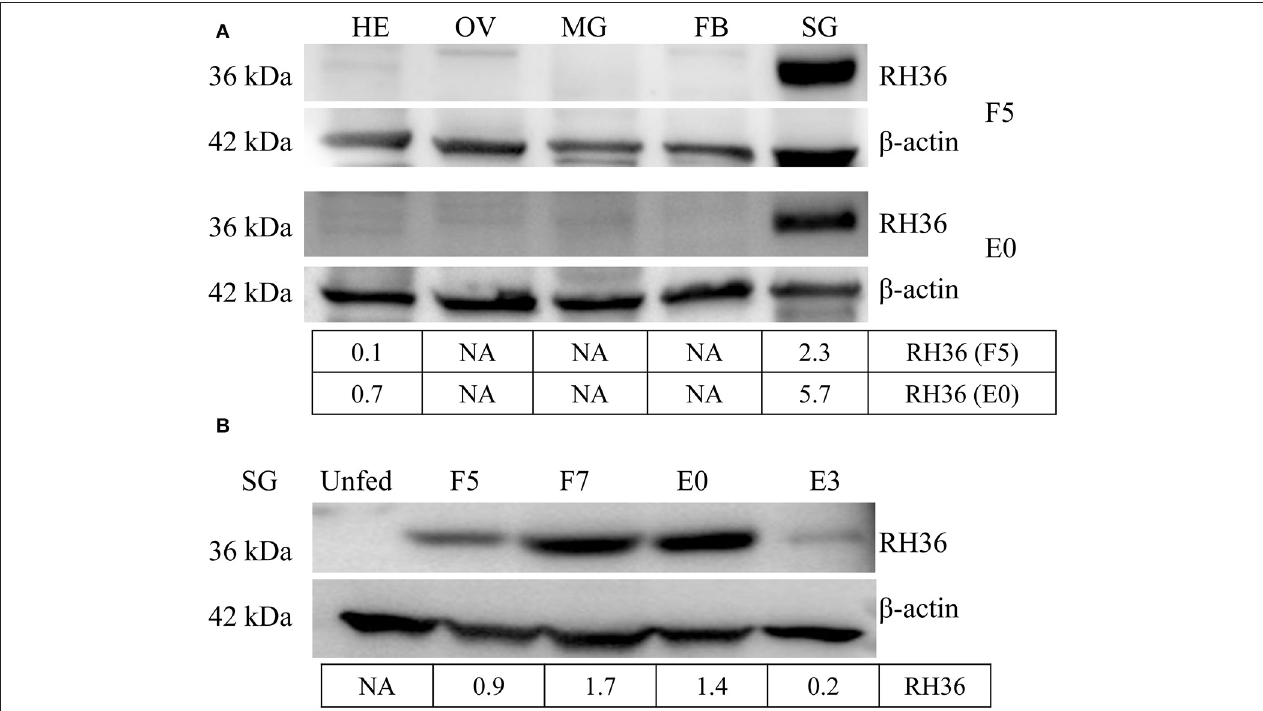
FIGURE 1 | RH36 is expressed uniquely in the salivary gland and expressed higher in 7-day-fed ticks and engorged ticks. Expression level of RH36 was detected at different organs from 5-day-fed ticks (upper panel, A ) and engorged ticks (lower panel, A ), and different development stages (B) using polyclonal antibody prepared by KLH binding RH36 polypeptide. Density analysis shows RH36 protein is induced by feeding and expressed characteristically in salivary glands. The protein level of RH36 was normalized to β -actin. FB, fat body; HE, hemolymph; OV, ovary; SG, salivary gland; MG, midgut; F5, at day 5 for blood feeding; F7, at day 7 for blood feeding; E0, on the day of engorgement; E3, at 3 days post-engorgement.